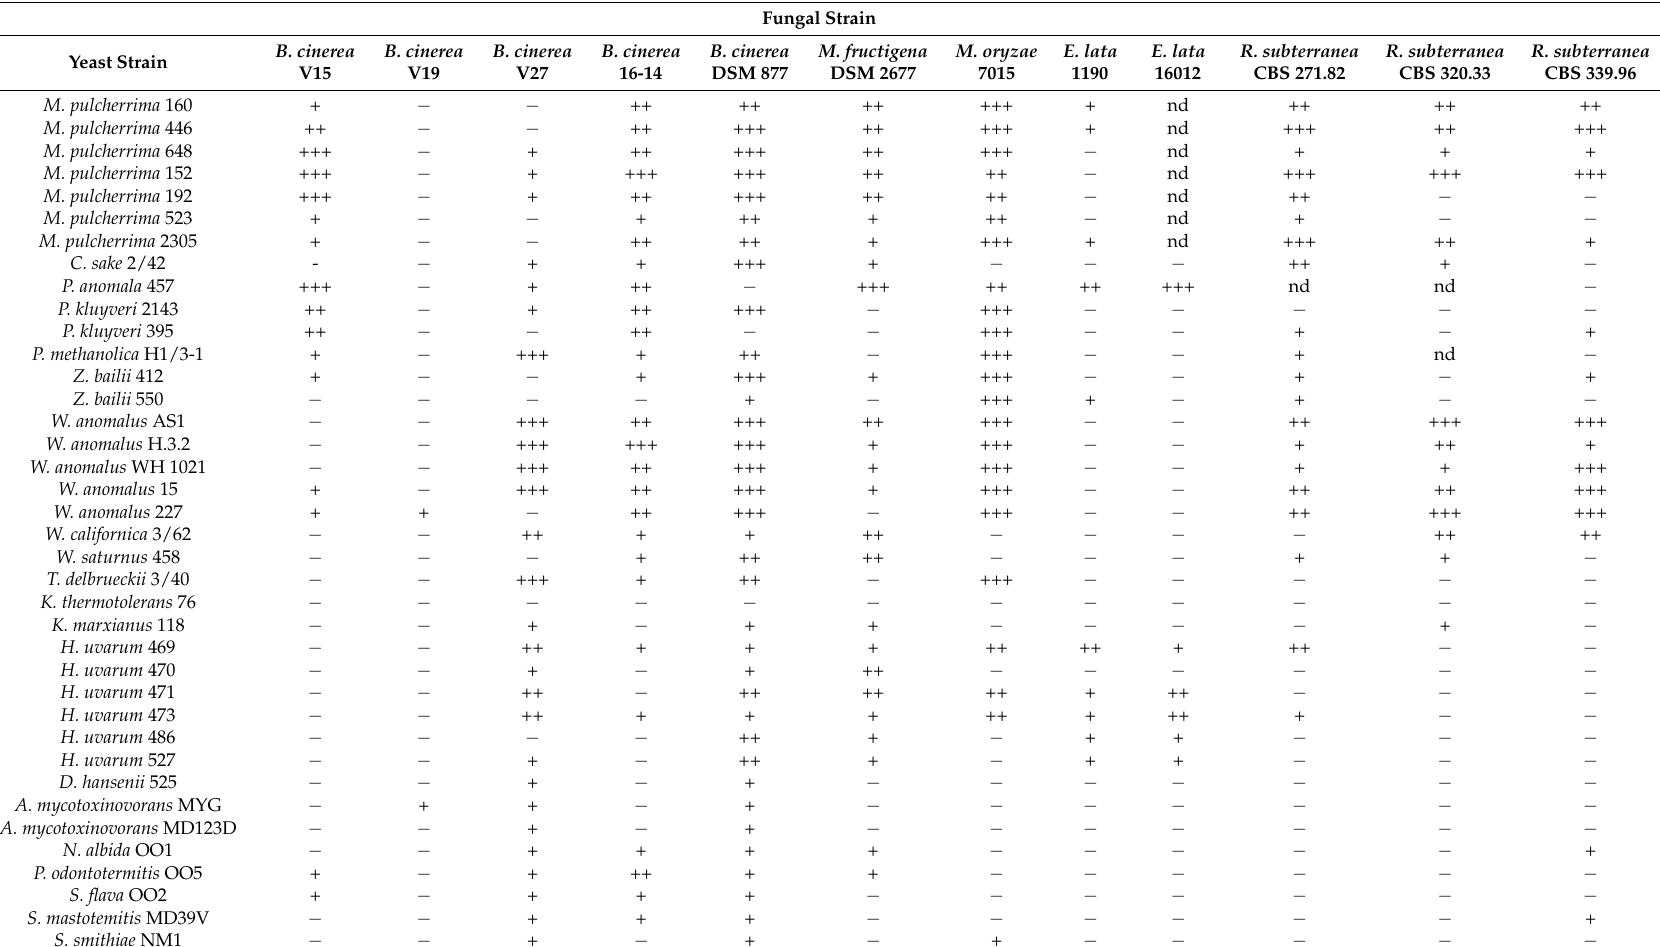
Table 3. Antagonistic activities of yeasts against fungi as observed on agar